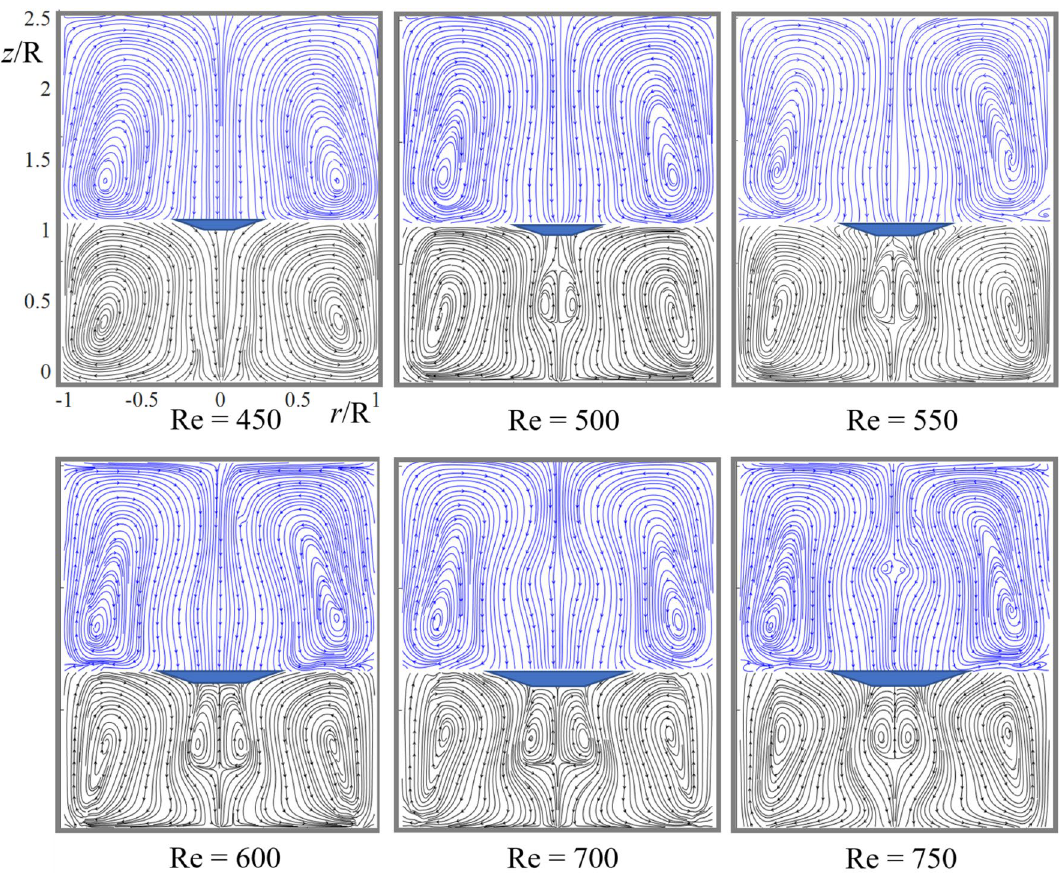
Figure 2. PIV streamline patterns show the development of dual vortex breakdown (VB) in the sealed